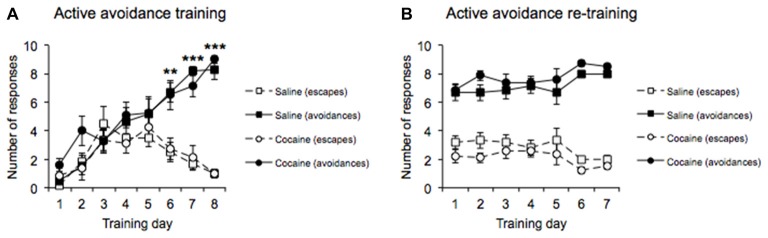
AA acquisition training data across 8 days (A) revealed increasing conditioned AA responses and decreasing escape responses as training progressed with no differences between drug pre-exposure conditions. AA re-training data across 7 days (B) in the straight alley maze configuration revealed a significantly greater number of conditioned AA responses than escape responses with no differences between drug pre-exposure conditions (±SEM, **p < 0.01, ***p < 0.0001).